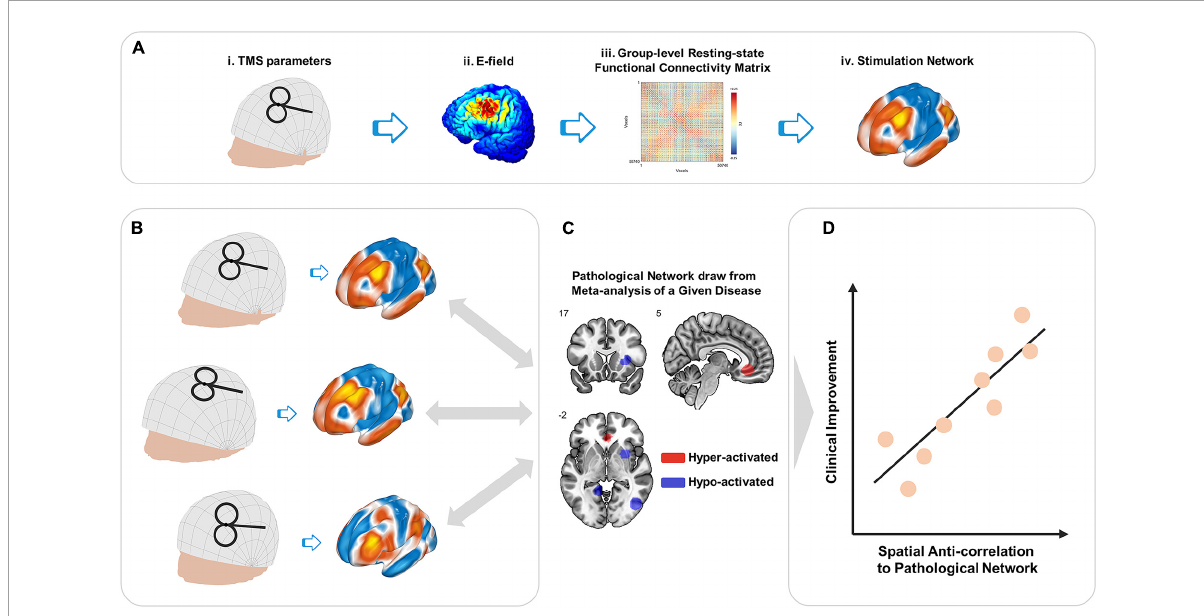
FIGURE1 Schematic illustration of network targeting model. (A) Stimulation network. For transcranial magnetic stimulation (TMS) administrated with a given combination of parameters (i), the generated E-filed (ii) defines direct TMS effects on the local cortical region. Group-level rsFC (iii) provides a visualization of the functional network affected via the stimulated cortical region, i.e., the stimulation network (iv). (B) Stimulation networks vary among individuals due to both the coil setting and geometry and productivity of individuals’ intra-cranial tissues. (C) Comparing to the pathological network of a given disease, (D) stimulation networks showing spatial anti-correlation are hypothesized to be associated with better clinical improvement induced by TMS (Fox et al.,